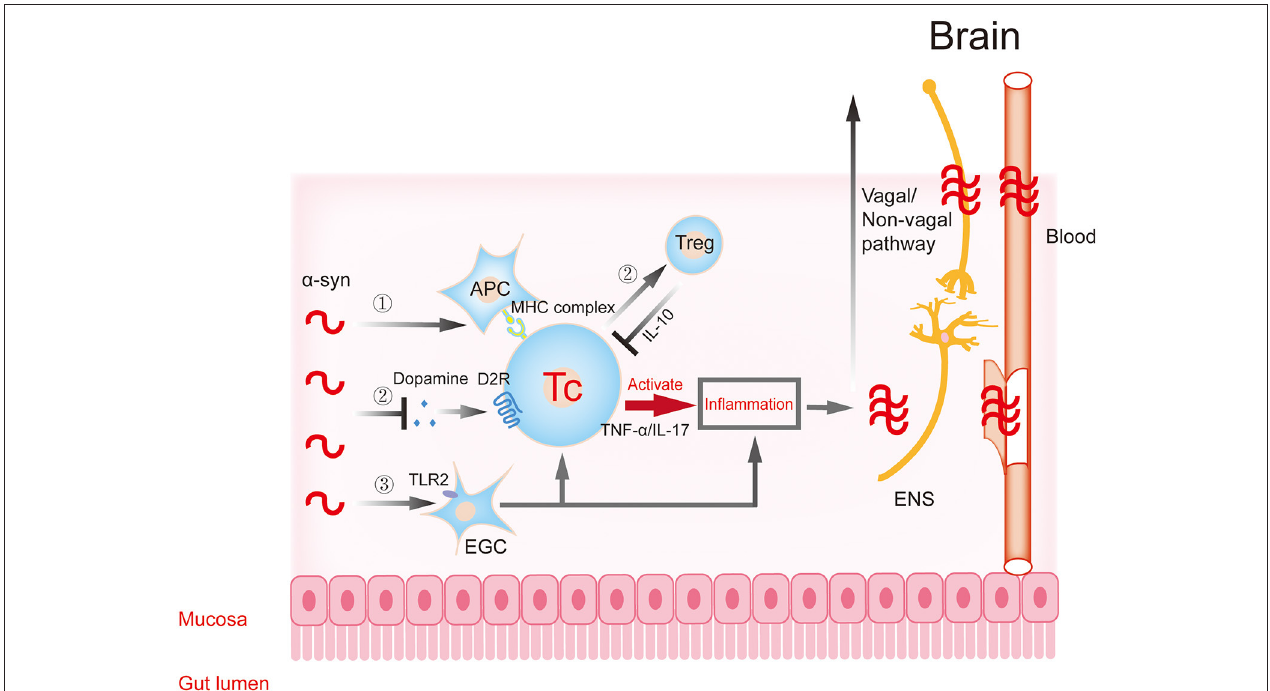
FIGURE 2 | Gastrointestinal immune inflammatory response participates in the progression of α -synuclein. α -Synuclein may activate T cells to trigger downstream inflammatory responses through APCs ( ‹ ) and EGCs ( fi ), resulting in traumatic changes in intestinal structure and function. The inflammatory reaction further aggravates the aggregation and toxicity of α -synuclein. The excessive accumulation of α -synuclein in intestinal neurons can inhibit synaptic vesicle transport and reduce dopamine production, then inhibit the transformation of T cells to protective regulatory T (Treg) cells, and aggravate inflammation ( › ). Dopamine in this process participates in T cell protective regulation through the dopamine receptor. The pro-inflammatory or anti-inflammatory reaction caused by the above processes further aggravate the aggregation and toxicity of α -synuclein. Subsequently, these changes affect the central nervous system (CNS) through the dual pathways of nerve (vagal and non-vagal circuits) and blood circulation. α -syn, α -synuclein; APC, antigen presenting cell; EGC, enteric glial cells; ENS, enteric nervous system.